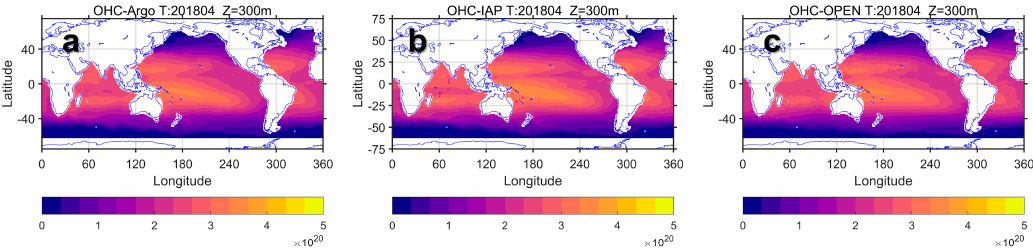
Figure 7. The spatial distribution of OHC300 (non-anomaly, unit: Joule) in ( a ) Argo, ( b ) IAP, and ( c ) OPEN in April